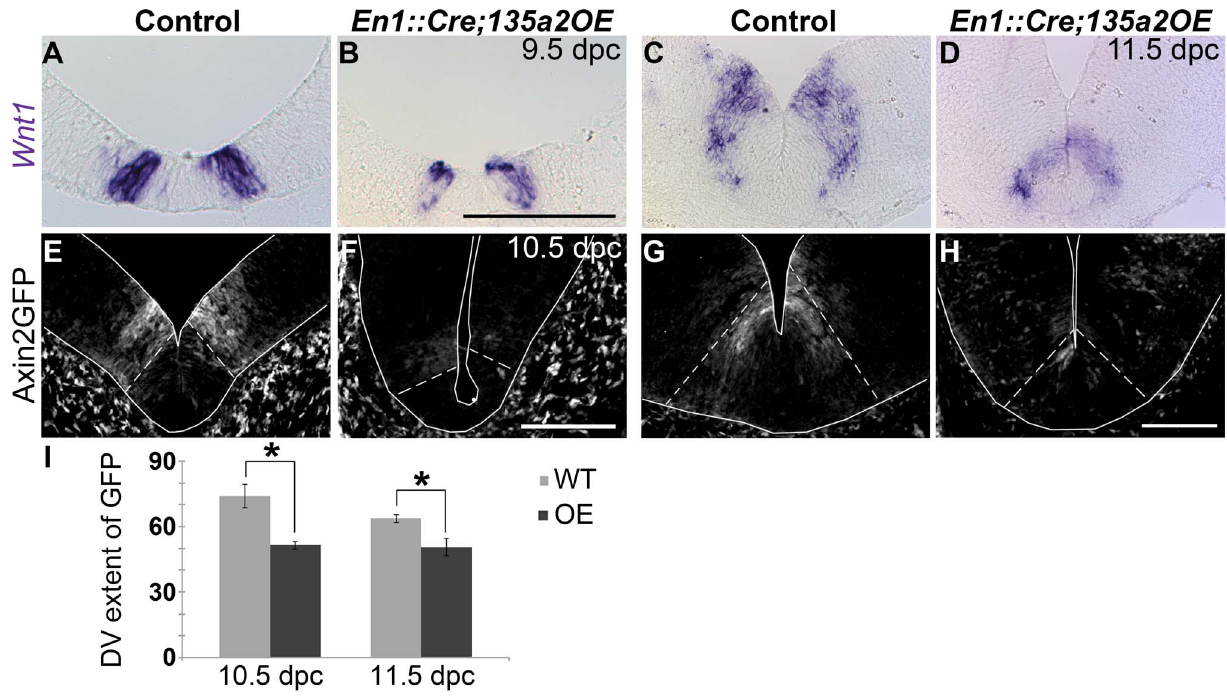
Figure 9. Increasing miR135a2 levels diminishes Wnt1 and Wnt signaling. (A–D) In situ hybridization in 9.5 dpc and 11.5 dpc En1::Cre;135a2OE embryos revealed a reduction in the size of the Wnt1 expression domain. (E–H) At 10.5 dpc, some Axin2::d2eGFP transgene activity was observed to be inside the Lmx1a domain (dotted white lines), but d2eGFP was predominantly detected outside of this domain. At 11.5 dpc d2eGFP only extend a few cell diameters outside of the Lmx1a domain (dotted white lines). In most mutant sections at both ages, the intensity of GFP labeling was diminished at all anterior-posterior levels of the ventral midbrain. (I) Quantification of the distance that GFP labeling was observed along the dorsal-ventral axis showed a 30% reduction in 10.5 dpc mutants (n=3; control mean=73.99 6 5.34 m M, mutant mean=51.50 6 1.77 m M; p- value=0.02) and a 21% reduction in 11.5 dpc mutants (n=3; control mean=63.68 6 1.72 m M, mutant mean=50.44 6 4.03 m M; p-value=0.04). (GFP labeled sections were outlined to accentuate tissue). Scale bars represent 100 m